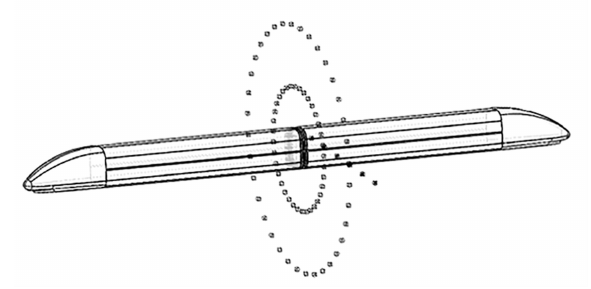
Fig. 12. Distribution of surface monitoring